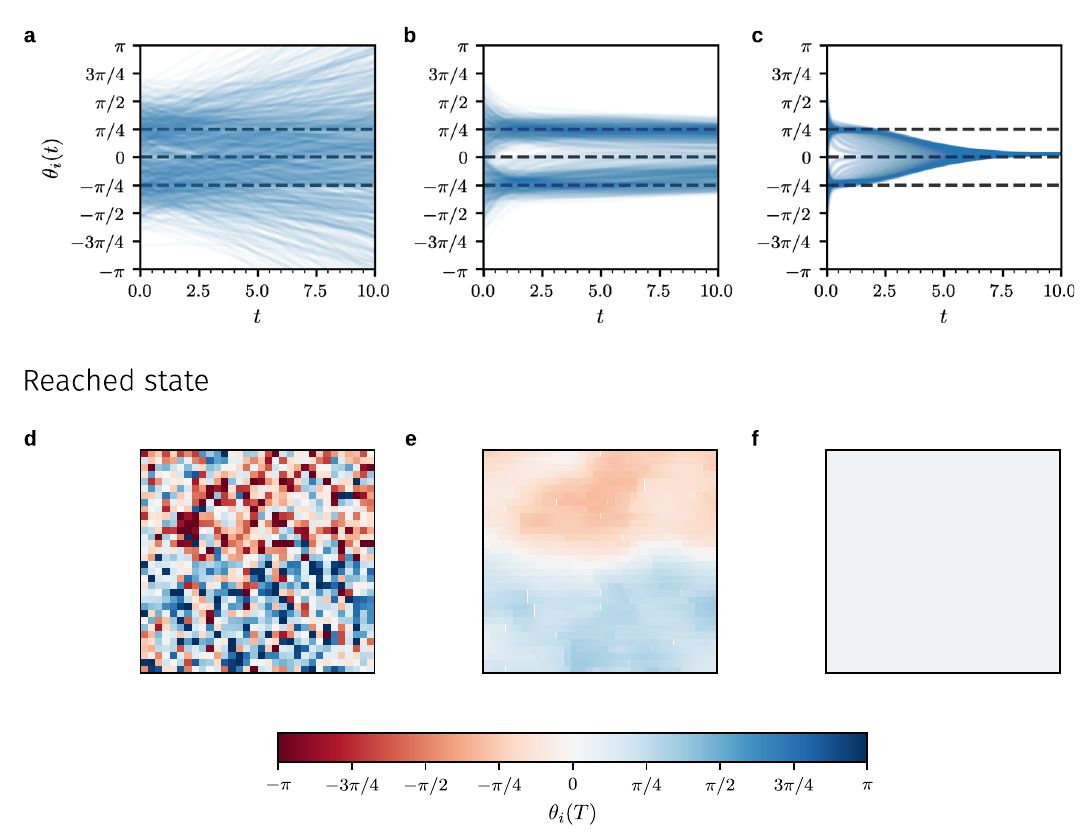
Fig. 5 Kuramoto dynamics and different target states. The evolution of the phases θ i ð t Þ (1 ≤ i ≤ N ) of N ¼ 1024 coupled Kuramoto oscillators [Eqs. (11) and (12)] that are arranged in a square lattice without periodic boundary conditions. We use a subcritical coupling constant K ¼ 0 : 01 K (cid:1) and set T ¼ 10. In all simulations, oscillator phases are initially distributed according to a bimodal Gaussian distribution with means (cid:4) π = 4 (top half of the lattice), π = 4 (bottom half of the lattice), and variance 0.5. The top panels show the evolution of θ i ð t Þ and the bottom panels show the spatial distribution of oscillator phases θ i ð T Þ at time T ¼ 10. Each pixel in the 32 ´ 32 bottom panels represents the phase value of one speci fi c oscillator in the reached state. a , d The control input is set to u i ð t Þ ¼ 1 for all i (uncontrolled dynamics), leading to increasing phase differences over time. b , e AI Pontryagin steers oscillator phases towards (cid:4) π = 4 and π = 4 by minimizing the loss function J 2 ð Θ ð T ÞÞ [Eq. (21)]. c , f AI Pontryagin synchronizes the system of coupled oscillators by minimizing the loss function J 1 ð Θ ð T ÞÞ [Eq. (19)]. The dashed black lines in panels ( a – c ) are guides-to-the-eye indicating phases with values (cid:4) π = 4, 0, and π = 4. The learning rate is 15 in panels ( b , e ) and it is 0.12 in panels ( c , f